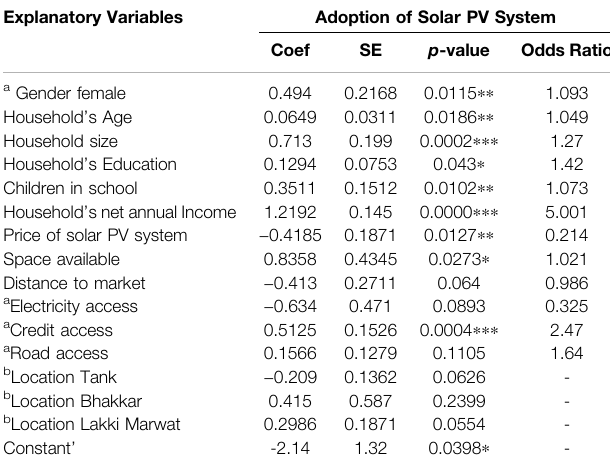
TABLE 4 | Logistic regression of solar photovoltaic system adoption